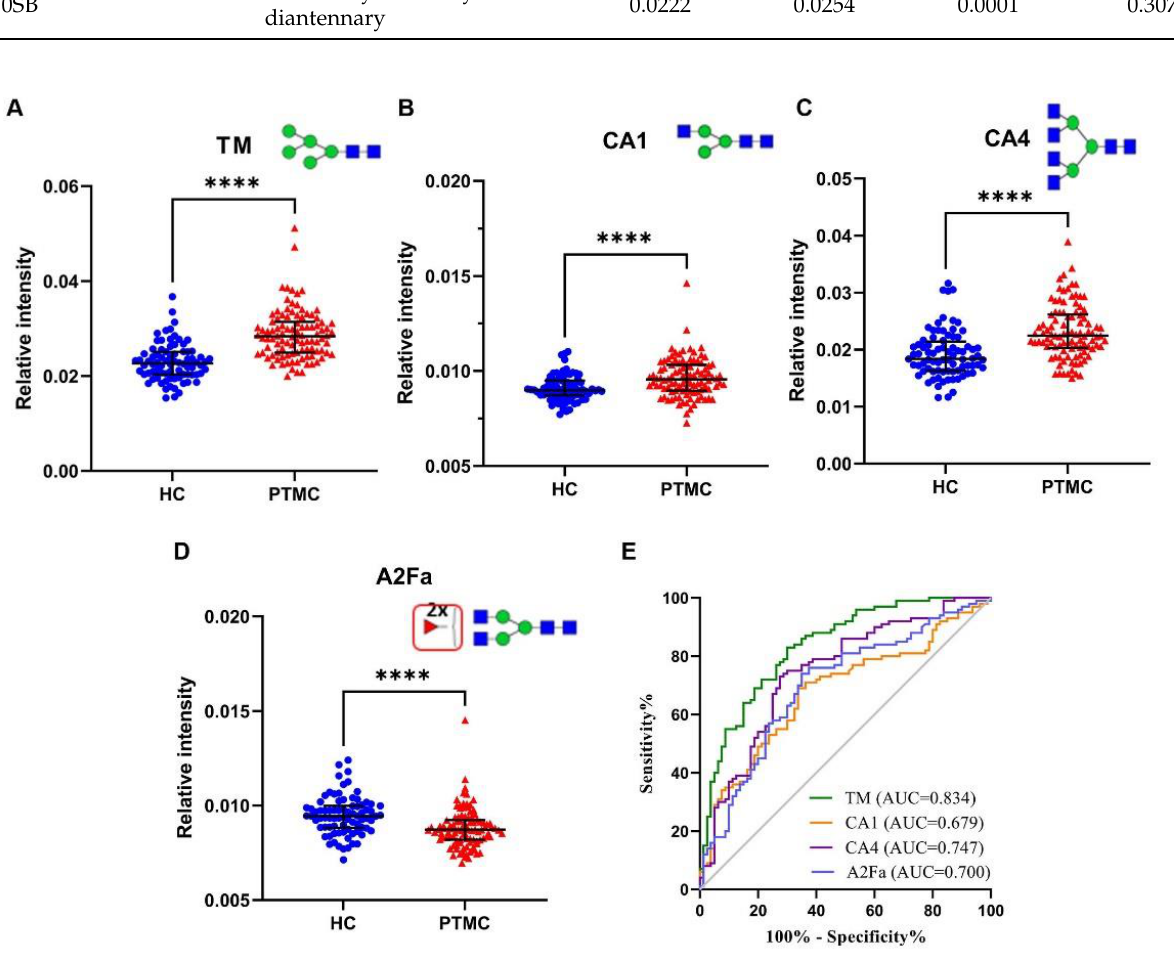
Figure 2. The scatter plots and ROC curve analysis of four prominently different derived N -glycan traits between PTMC and HC groups. ( A ) scatter plot for TM, ( B ) scatter plot for CA1, ( C ) scatter plot for CA4, ( D ) scatter plot for A2Fa, and ( E ) ROC curve analysis for four differential expressed derived glycan traits. **** represents p -value < 0.0001 (after multiple testing correction). Notes: mannose, green circle; fucose, red triangle; GlcNAc, blue square. Abbreviations: ROC, receiver operating characteristic; PTMC, papillary thyroid microcarcinoma; HC, healthy control; AUC, area under the curve.